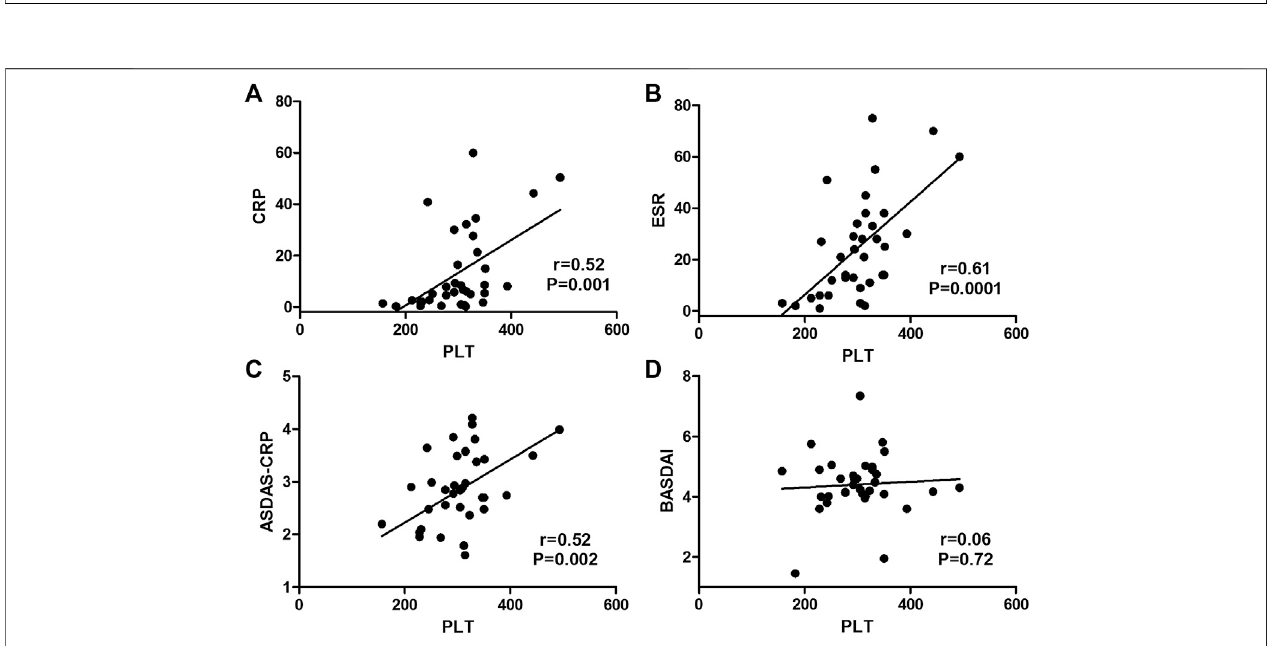
FIGURE 2 | Correlations of platelet count with disease activity markers in AS patients. (Platelet count had a moderate correlation with CRP (A) and ASDAS-CRP score (C) and had a signi fi cant correlation with ESR (B) , but it was not correlated with BASDAI score (D) .)